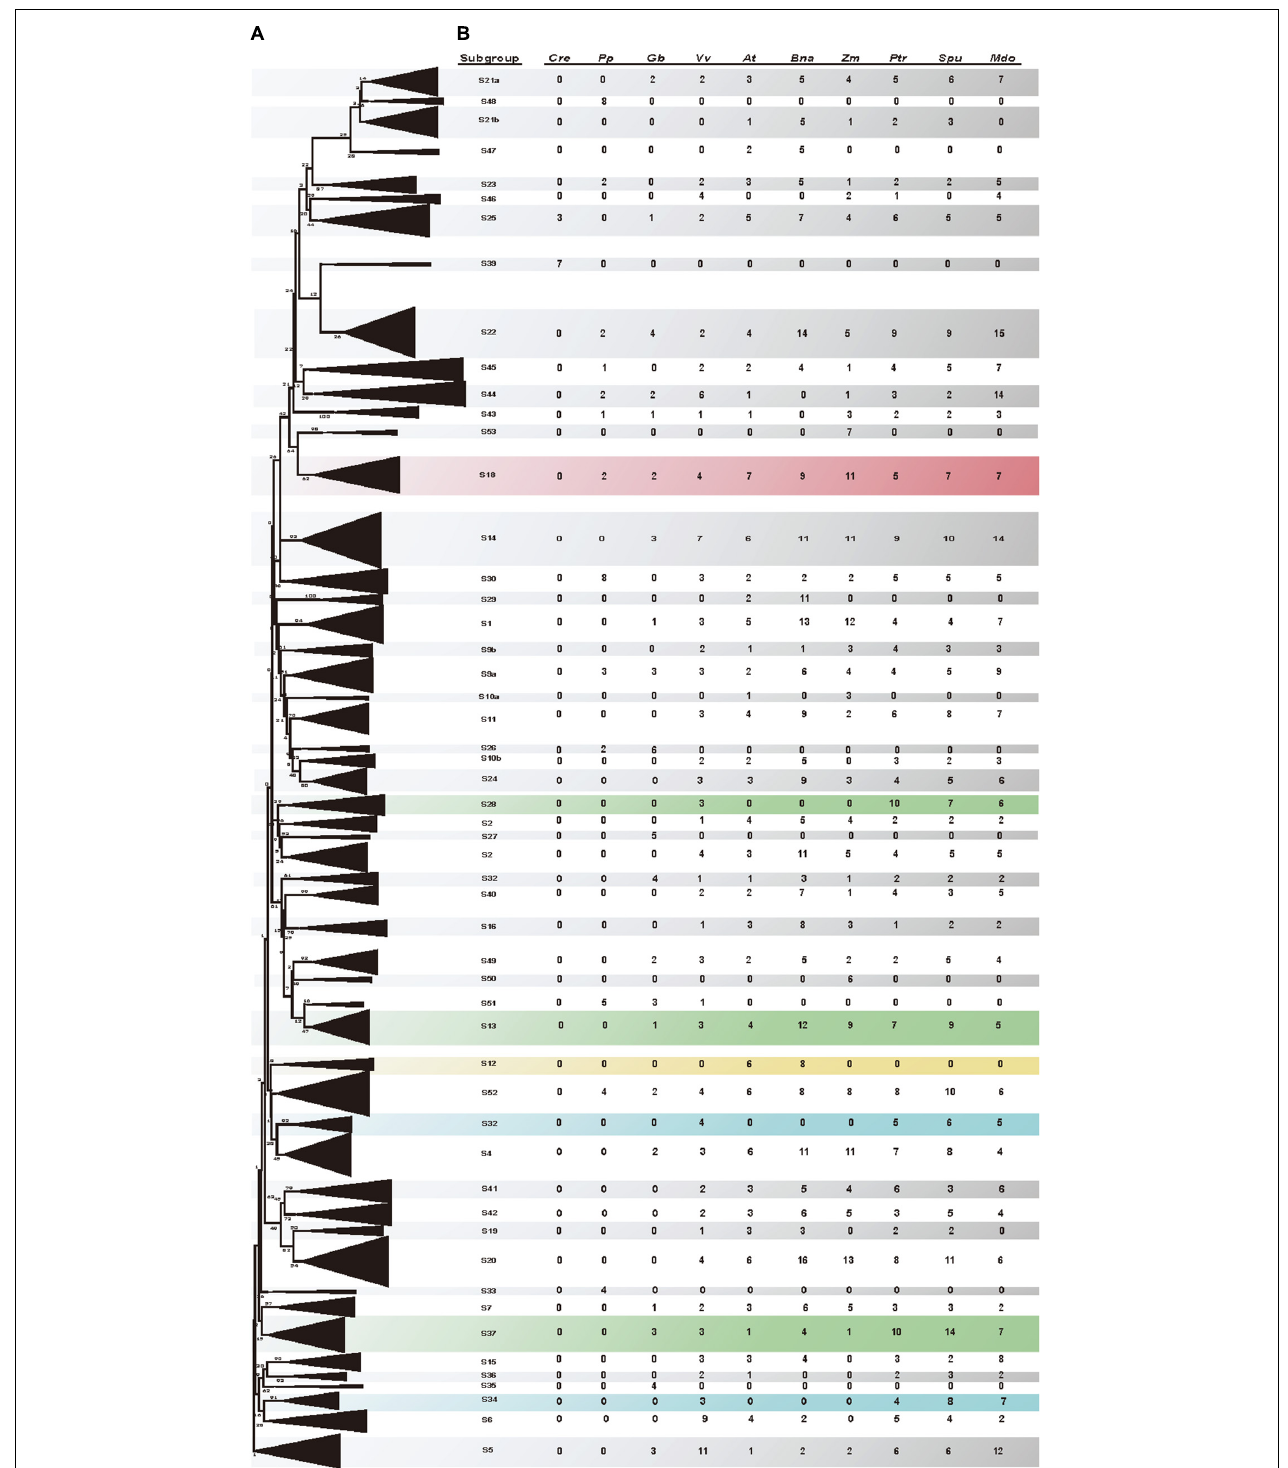
FIGURE 4 | Phylogenetic tree of poplar, willow, A. thaliana , P. patens , C. reinhardtii , grapevine, maize, B. napus , apple, and ginkgo R2R3 MYB proteins. (A) Neighbor-joining phylogenetic tree (Supporting sequences 4) and Maximum likelihood (ML) phylogenetic tree (Supporting sequences 5) constructed using 1,431 amino acid sequences (Supporting sequences 5) including all of the R2R3-MYB proteins. Folding triangles represent 53 subgroups of the R2R3 MYB protein cluster, consistent with OrthoFinder clustering orthogroup, and prediction of the function of the subgroups, each triangle represents a R2R3-MYB